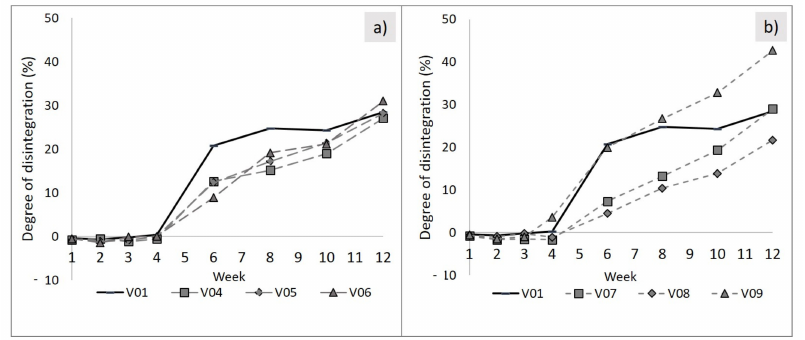
Figure 3. Influence of filler type and amount on the degree of disintegration, PLA/PBS (7:3) with 5 phr ( a ) and PLA/PBS with 15 phr content ( b ), measured on 2 mm thick plates. Compositions: R01: unfilled reference; V04/V07: plus 5/15 phr coarse talc; V05/V08: plus 5/15 phr fine talc; V06/V09: plus 5/15 phr